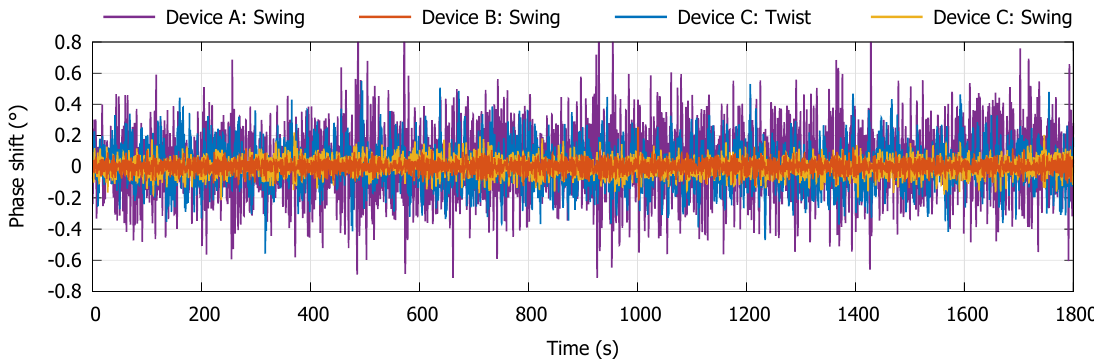
Figure 14. Phase difference output of the resistive readout with no flow over a period of 1800 s. The sensor’s channel is kept at a constant pressure of 5 bar (gauge pressure) while its outlet is closed off.